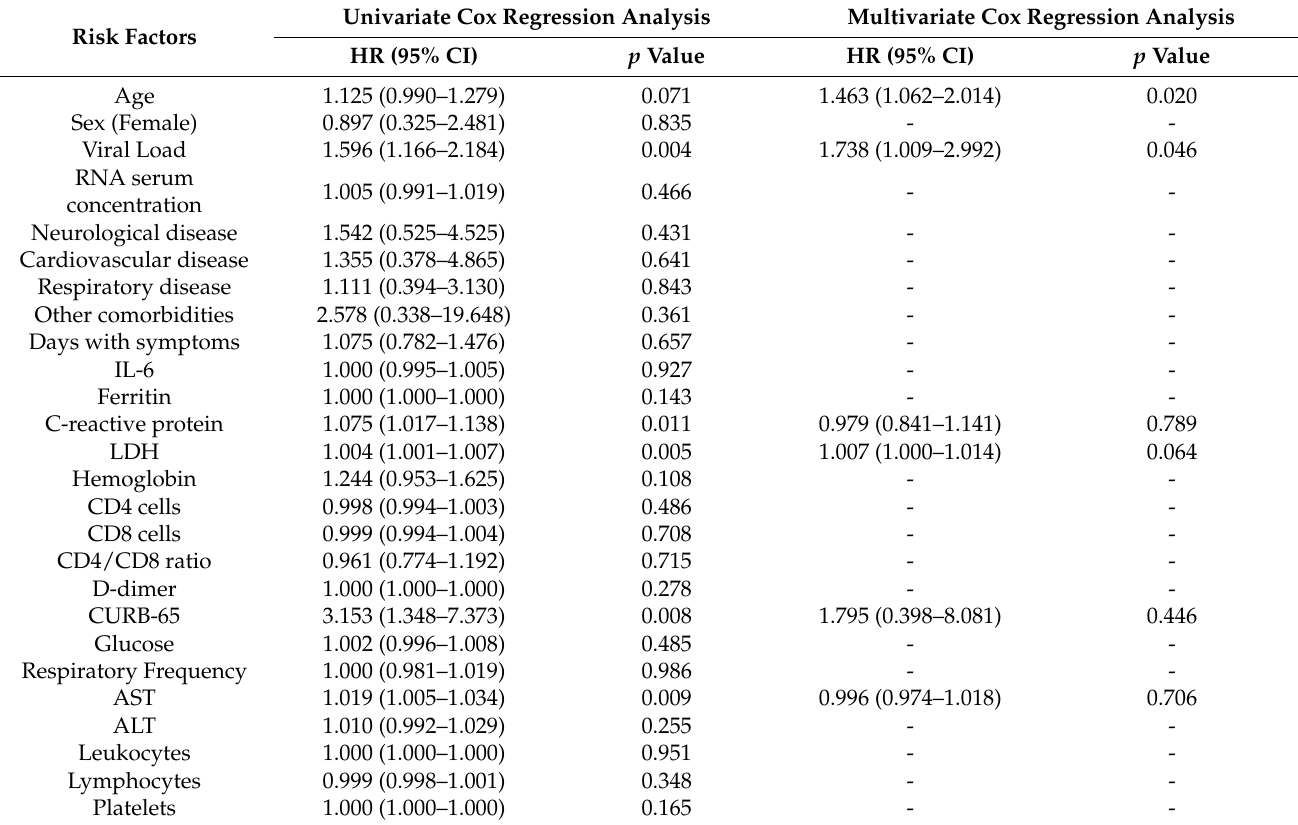
Table 2. Bivariate and multivariate Cox proportional hazards regression model for COVID-19 mortality.